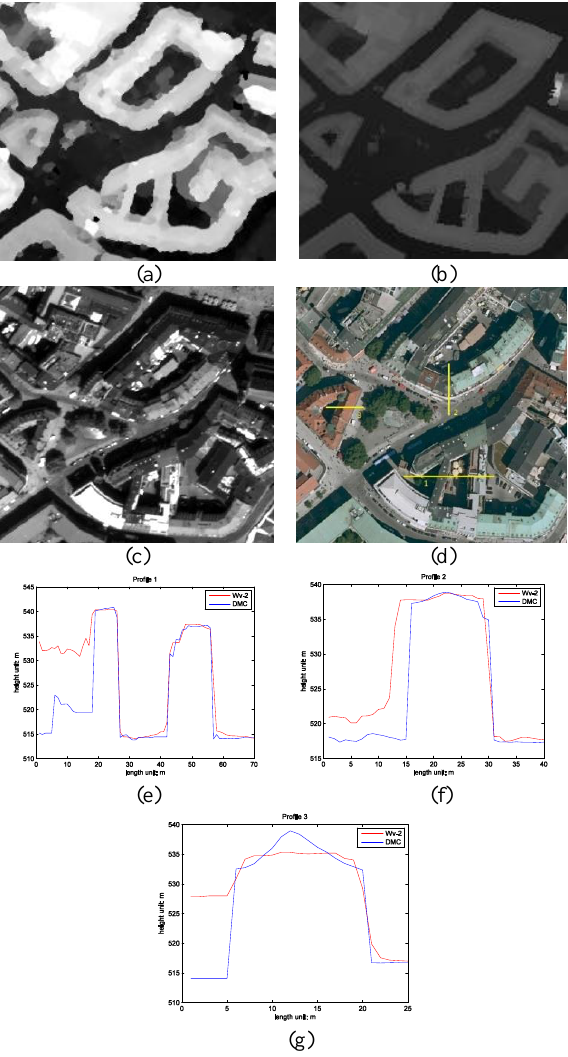
Figure 11: DSM Profiles Analysis A subsection area of the DSMs generated from satellite imagery and airborne photography are separately shown in Fig. 11 (a) and (b). Comparing the reference airborne photography DSM with the satellite data’s DSM, the boundary of the buildings are sharper. The corresponding area on the original satellite image is depicted in Fig. 11 (c). It is visible, that the side of the building which is covered by a cast shadow performs worse than other sides. The boundary between the buildings and streets have clearer results when there is no shadow at all. Moreover, three Figure 10. Height difference with the aerial photography DSM height profiles are extracted from the test area. The profiles on (a) ground points (b) roof points the orthophoto is shown in Fig. 11 (d). Comparing the height differences of the profiles on the reconstructed DSM and the aerial photography DSM, the results are shown in Fig 11 (e),